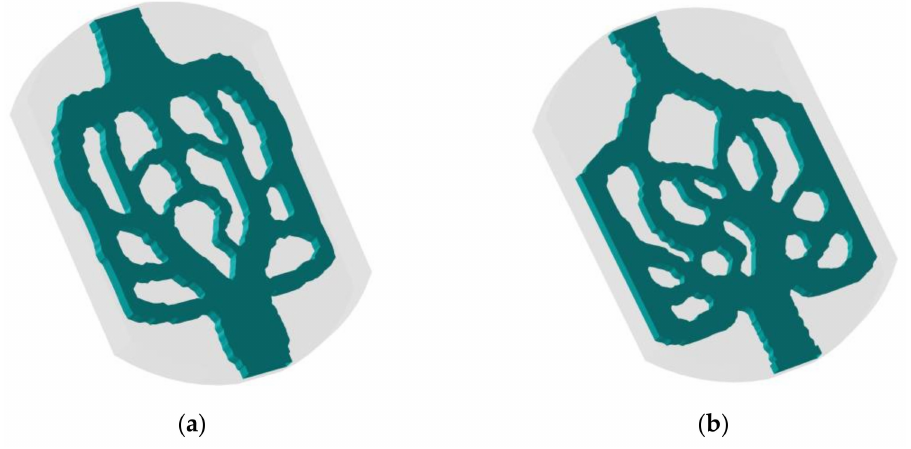
Figure 4. 3D topology structure. ( a ) M1; ( b ) M2.